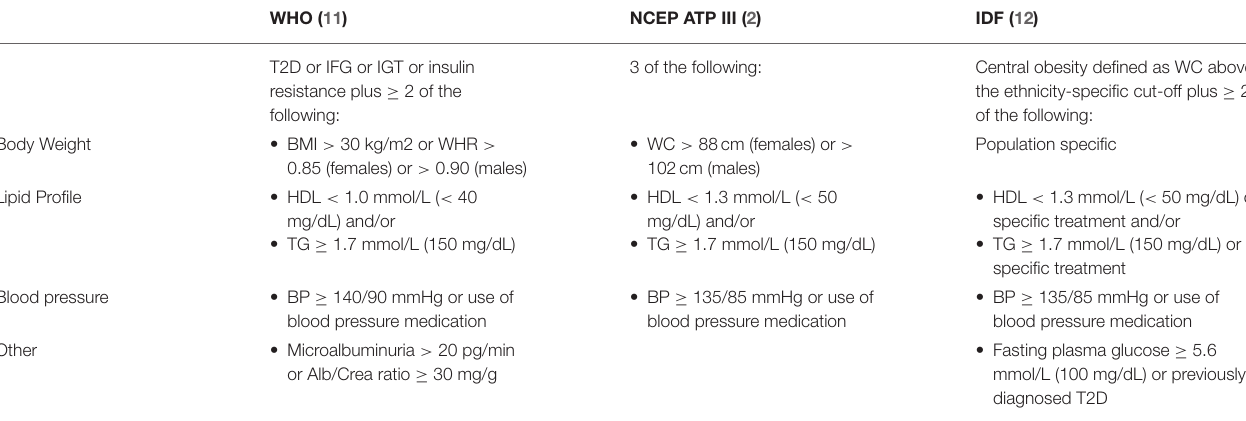
TABLE 1 | Clinical definitions of the cardiometabolic syndrome based on the National Cholesterol Education Program (NCEP) Expert Panel on Detection, Evaluation, and Treatment of High Blood Cholesterol in Adults Adult Treatment Panel III, the International Diabetes Federation (IDF), and the World Health Organization (WHO). WHO